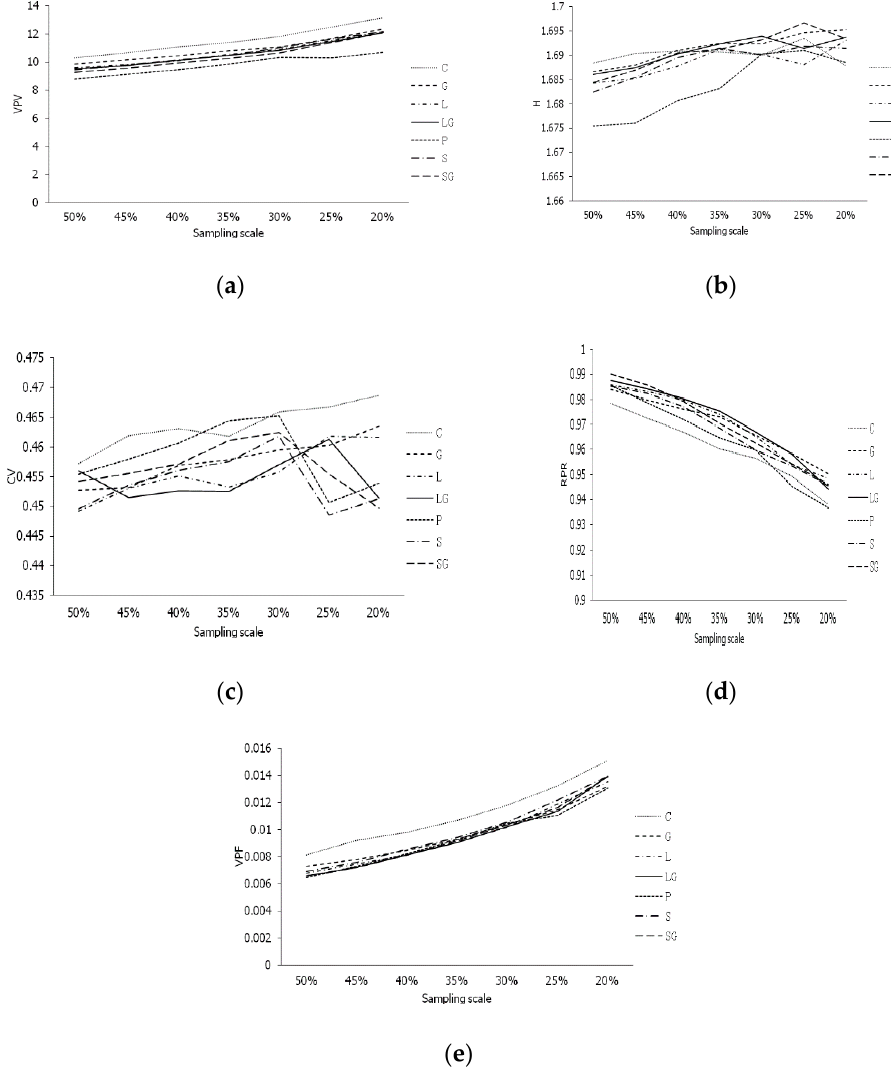
Figure 3. Tendency of parameters for sampling strategies in different sampling scales. ( a ) Ten- dency of VPV ; ( b ) Tendency of H ; ( c ) Tendency of CV ; ( d ) Tendency of RPR ; ( e ) Tendency of VPF . Shannon–Weaver diversity index ( H ), coefficient of variation ( CV ), variance of phenotypic value ( VPV ), variance of phenotypic frequency ( VPF ), and ratio of phenotype retained ( RPR ). C, G, L, LG, P, S, and SG stand for Constant strategy (C), Genetic diversity index strategy (G), Logarithm strategy (L), Genetic diversity index adjusted with logarithmic proportional strategy (LG), Proportional strategy (P), Square root strategy (S), Genetic diversity index adjusted with square root proportional strategy (SG),